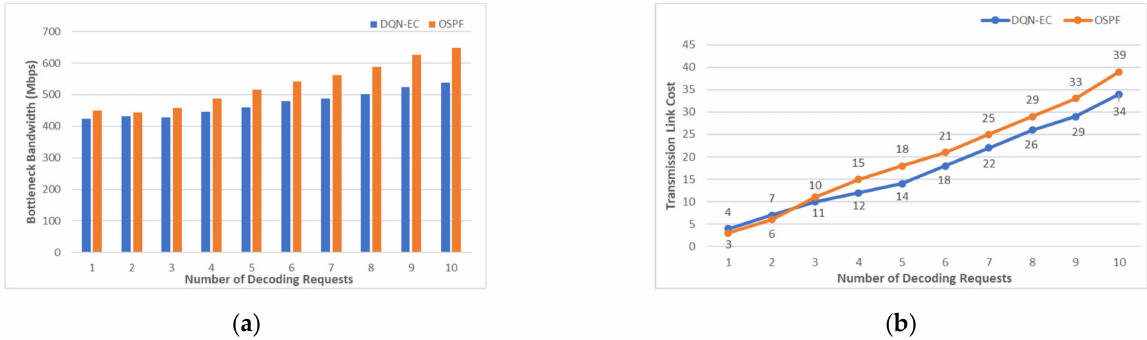
Figure 11. Graphs of BB r , TL r by equation 11 as: ( a ) Bottleneck bandwidth based on number of decoding requests; ( b ) Transmission link cost based on number of decoding requests.